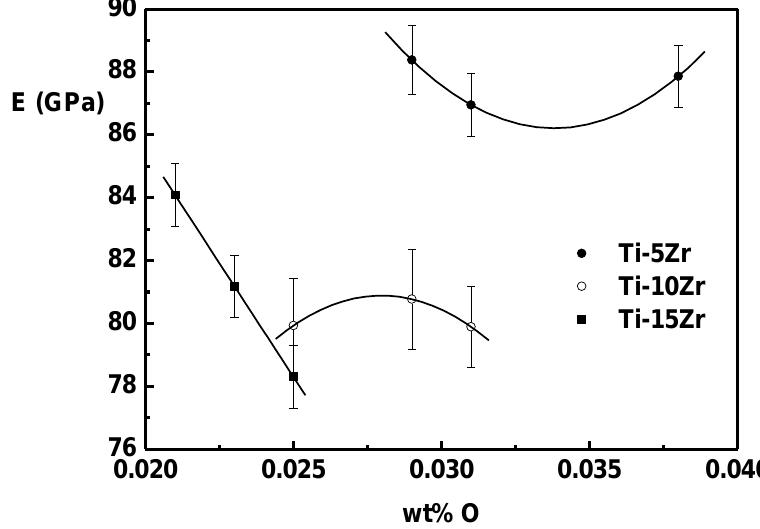
Figure 5. Elasticity modulus as a function of oxygen content for Ti-Zr